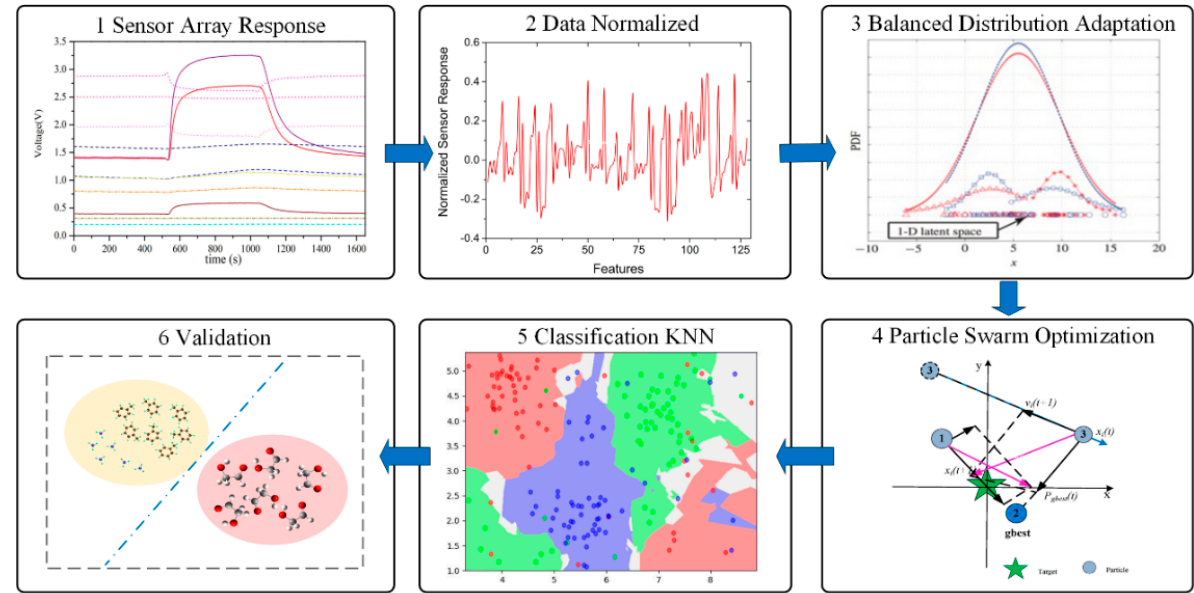
Figure 5. Steps of the BDA developed drift compensation